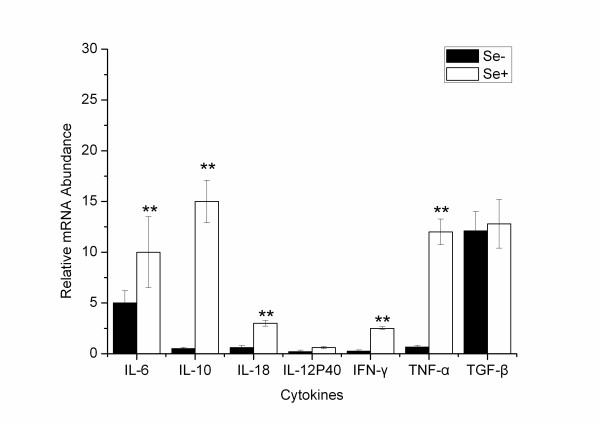
Liver cytokine expression in infected Se-deficient or adequate mice. Cytokine mRNA expression was determined in liver samples from each Se-deficient mice. C57BL/6 mice were infected with L. monocytogenes. Livers were obtained from infected Se-adequate and Se-deficient mice at 72 h post infection. Data are presented as relative mRNA abundance normalized to levels of β-actin. Mean ± SD of expression levels for N = 5 in each infected group is indicated. *p < 0.05, **p < 0.01.